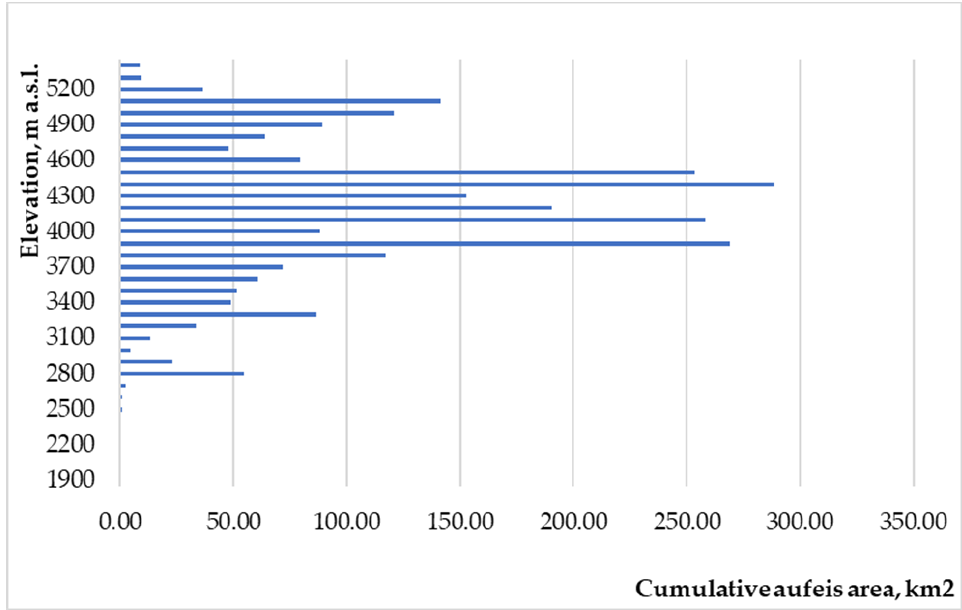
Figure 5. Plot of the cumulative Aufeis area distribution relatively to elevation in the Kunlun Moun- tains on northern edge of the Qinghai-Tibet Plateau, West China.